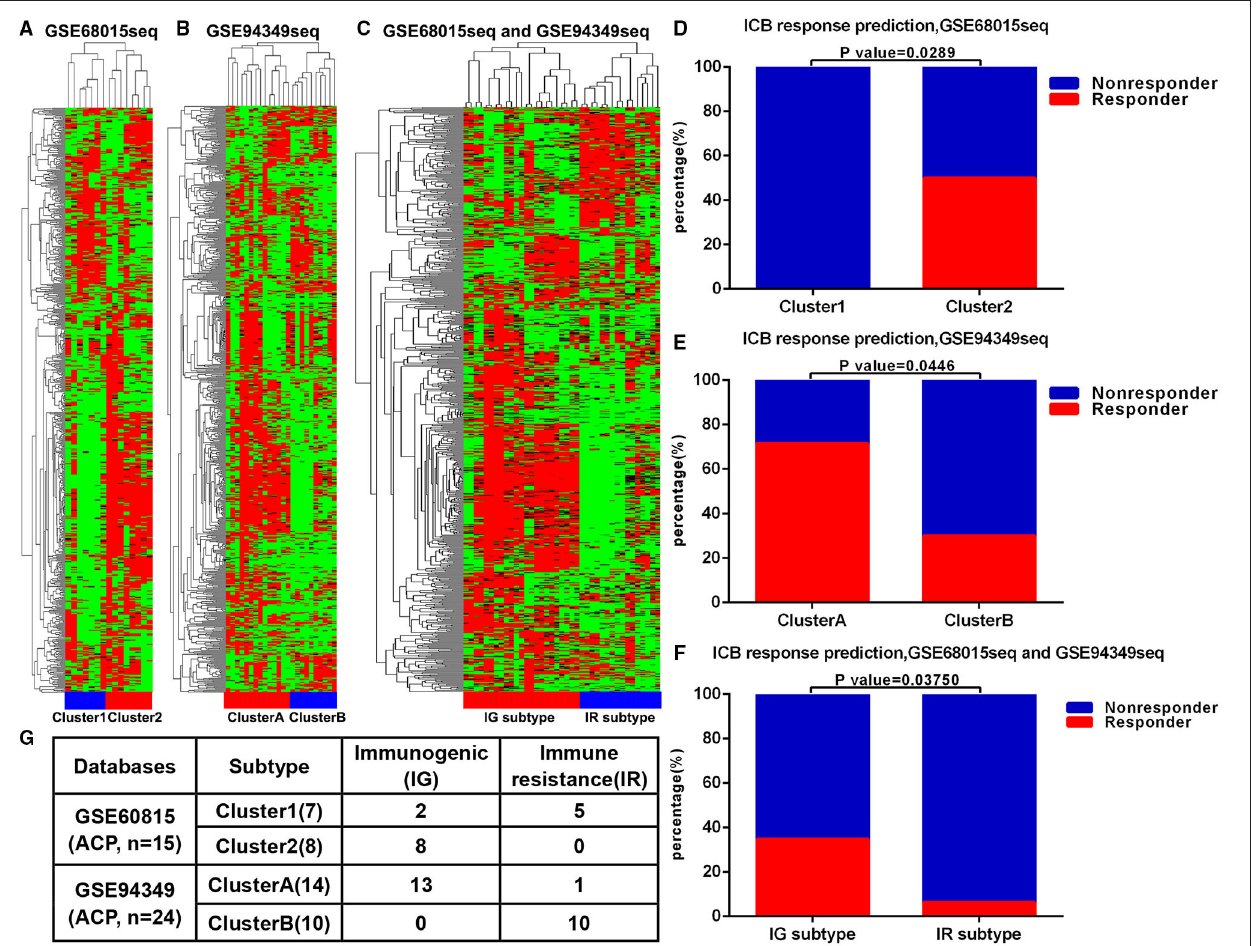
FIGURE 1 | ACPs classification based on immune infiltration. (A) The immune microenvironment (IME) of ACPs in the GSE68015 database could be divided into two different clusters, namely cluster 1 and cluster 2. (B) The IME of ACPs in the GSE94349 database could also be divided into two different clusters (cluster A and cluster B). (C,G) After merging these two databases, ACPs in the cluster 1 group could be matched with ACPs in the cluster B group well, and ACPs in the cluster 2 group could be matched with ACPs in the cluster A group well. (D–F) The accumulative bar diagram showed that the ACPs with cluster 2 and cluster A (50%, 4/8; 71.43%, 10/14) were more likely to respond to ICB immunotherapy than the ACPs with cluster 1 and cluster B (0%, 0/7; 30%, 3/10). (G) Immune classification and naming of ACPs. ICB, immune checkpoint blockade; IG, immunogenic; IR, immune